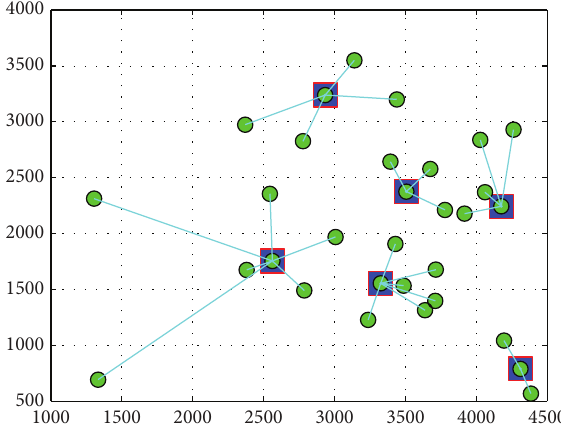
Figure 6: Experiment platform.